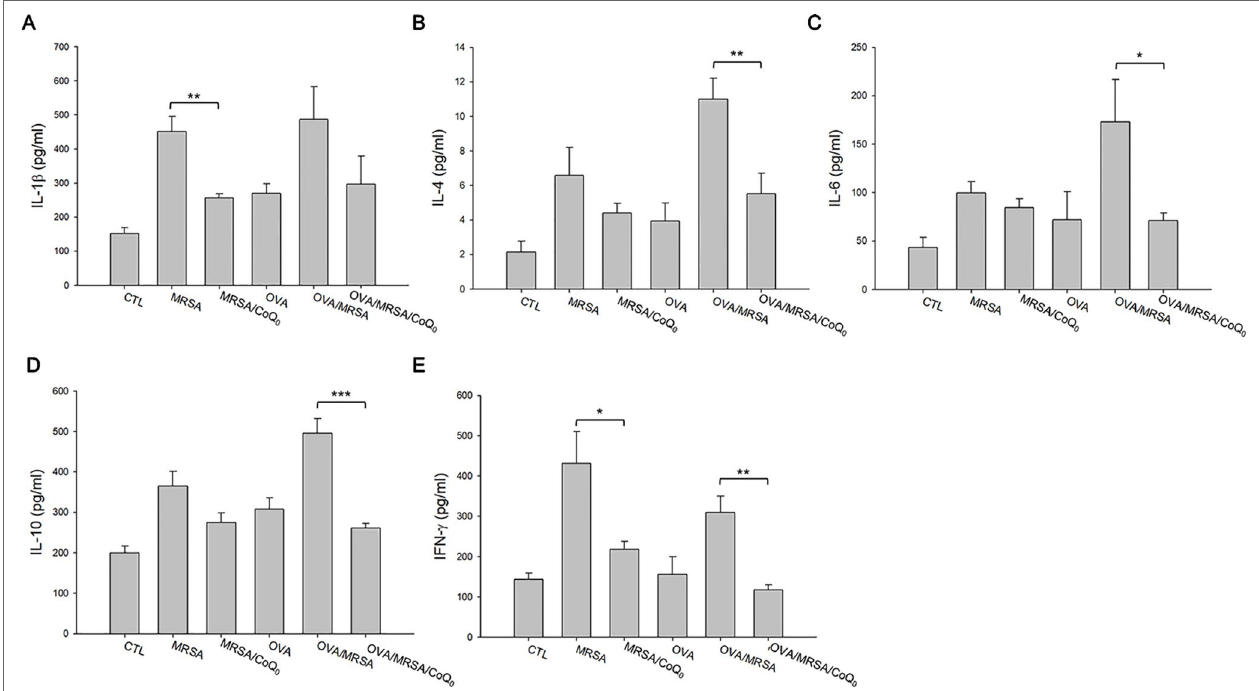
FIgURE 6 | CoQ 0 inhibits AD-like mouse skin inflammation based on cytokine assay. (A) IL-1β. (B) IL-4. (C) IL-6. (D) IL-10. (E) IFN-γ. Each value represents the mean ± SEM (n = 6). *** p < 0.001; ** p < 0.01; * p <